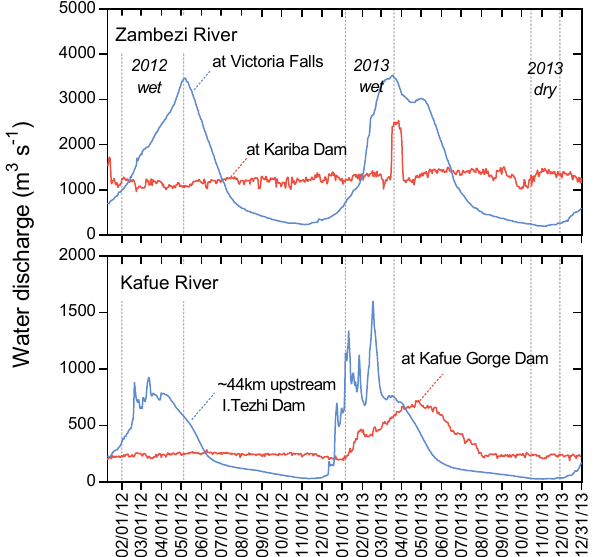
Figure 2. Water discharge between January 2012 and January 2014 for (a) the Zambezi River at Victoria Falls and at Kariba Dam, and (b) for the Kafue River at Hook Bridge located upstream of the Itezhi Tezhi Reservoir and at the Kafue Gorge Dam (data from Zam- bia Electricity Supply Corporation Limited, ZESCO). Bars refer to the three periods during which field campaigns were